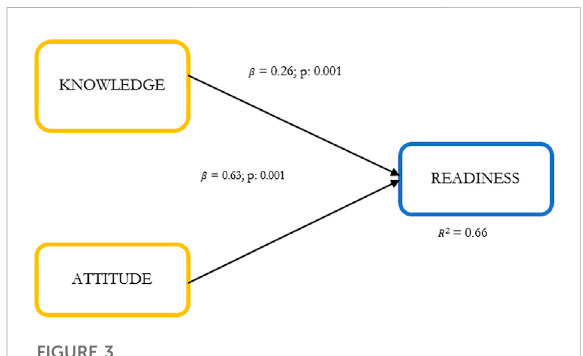
FIGURE 3 Final model with the standardized regression coef fi